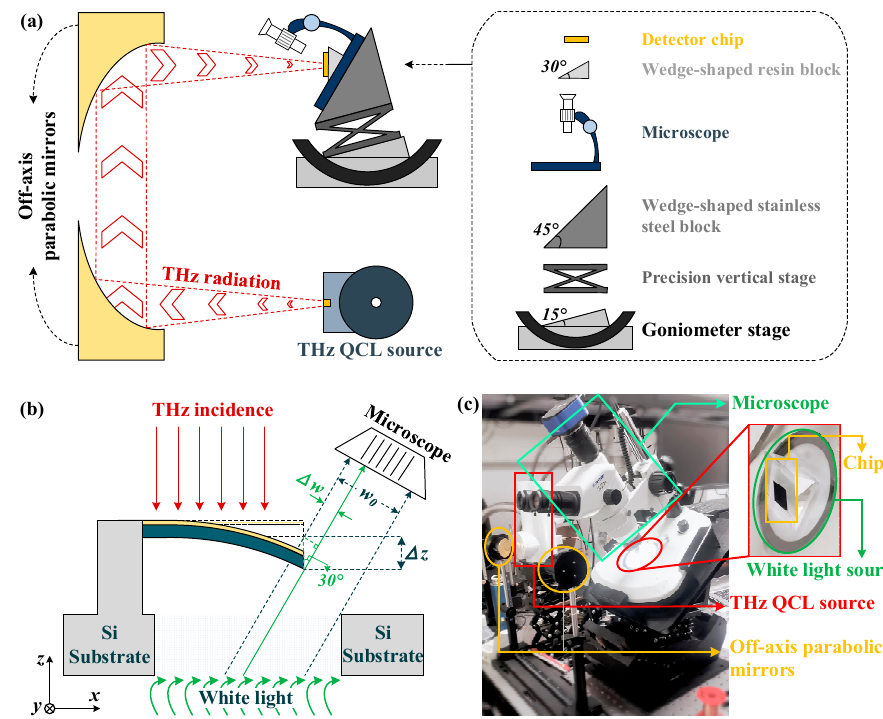
Figure 11. ( a ) Schematic diagram of the experimental system. ( b ) Schematic diagram of the relation- ship between optical slit width and detector displacement response. ( c ) The photo of experimental system, and the magnified view of detector chip.